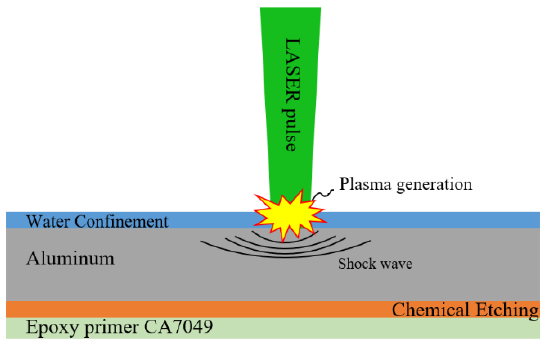
Figure 1. Schematic illustration of the laser shock stripping process adapted from [9].